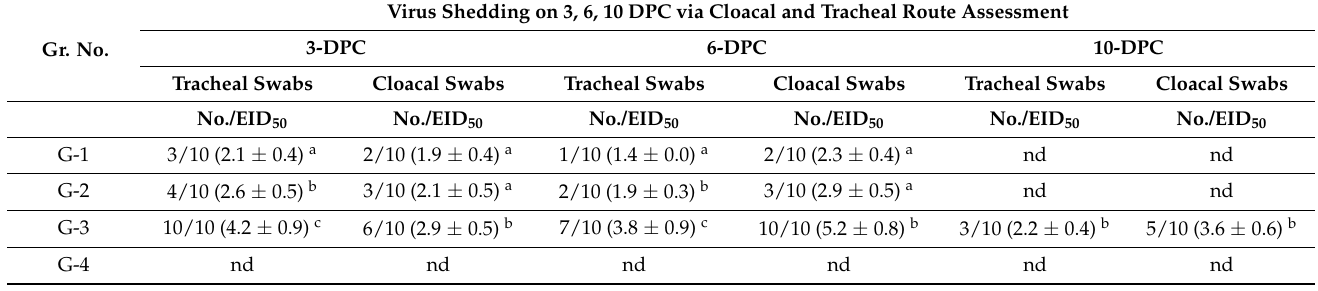
Table 3. Virus shedding for different groups at week 3, 6, 10 days